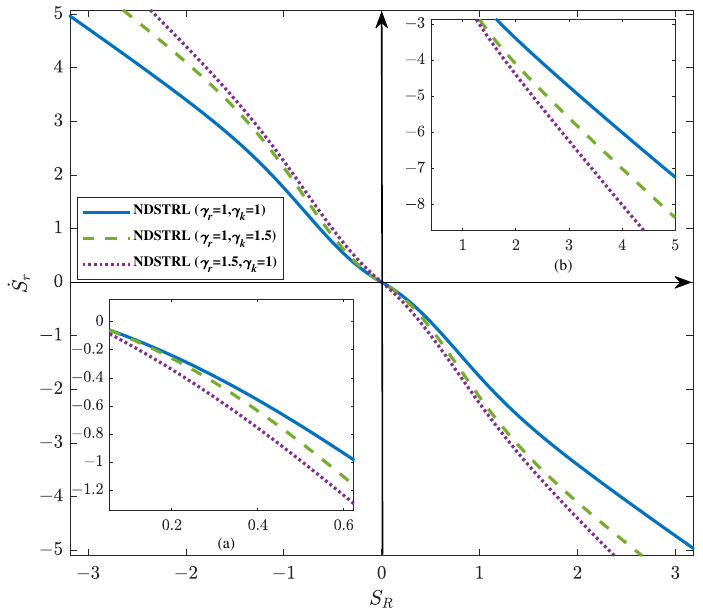
Figure 6. Comparison of NSTRL and